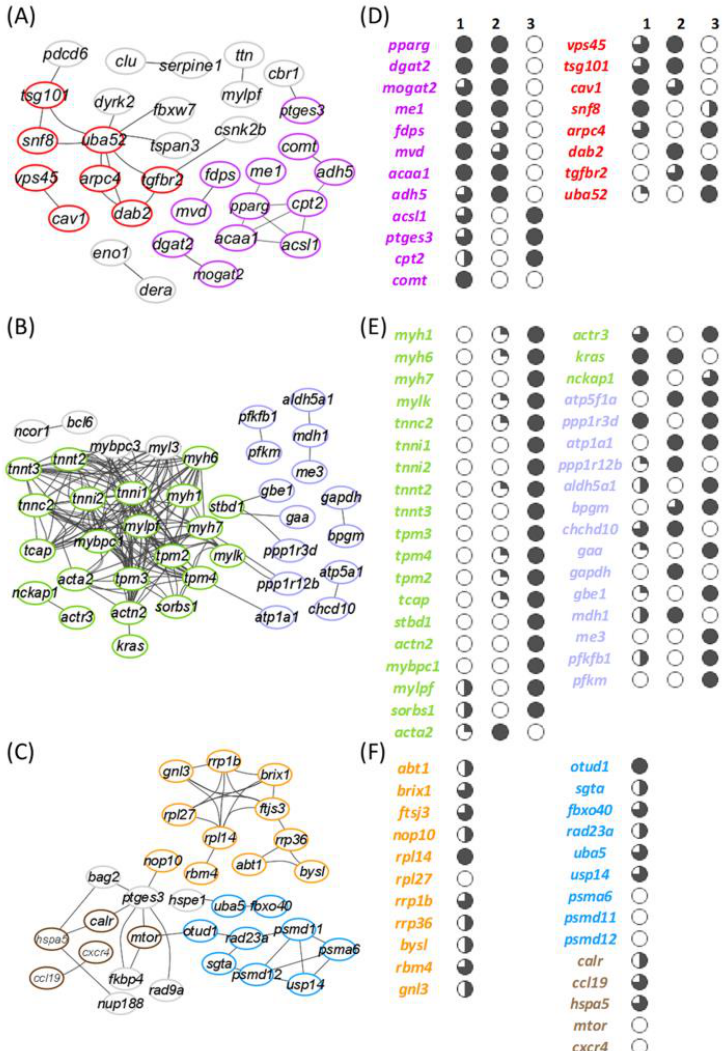
Figure 6. Protein–protein interaction plots and expression patterns of enriched processes at the end of the mild-hypoxia conditioning period (t 45H ) before ( A , D ) and after exhaustive exercise ( B , E ), and at the end of the normoxia recovery period (t +21N ) after exhaustion exercise ( C , F ). Edges between nodes shows significant relations (FDR < 0.05; STRING confidence score > 0.7). Colours represent genes related to the following enriched biological processes: small molecule metabolic process (purple), vesicle-mediated transport (red), muscle contraction (green), generation of precursors of metabolites and energy (violet), ribosome biogenesis (orange), small protein conjugation or removal (blue), and positive regulation of locomotion (brown). Numbers above columns indicate the comparison in the RNA-seq analysis (1: M-HYP vs. N; 2: M-HYP vs. N-PF; 3: N-PF vs. N). Sliced symbols in ( D ) and ( E ) represent the comparison between the gene expression log 2 FC values in the respective comparison for each gene. White circles represent the lowest log 2 FC values, whereas the black circles represent the highest. Genes in ( C ), forming a category in the interaction plot, were ordered by their log 2 FC in comparison 1, and sliced symbols in ( F ) were then applied for all the genes at the same